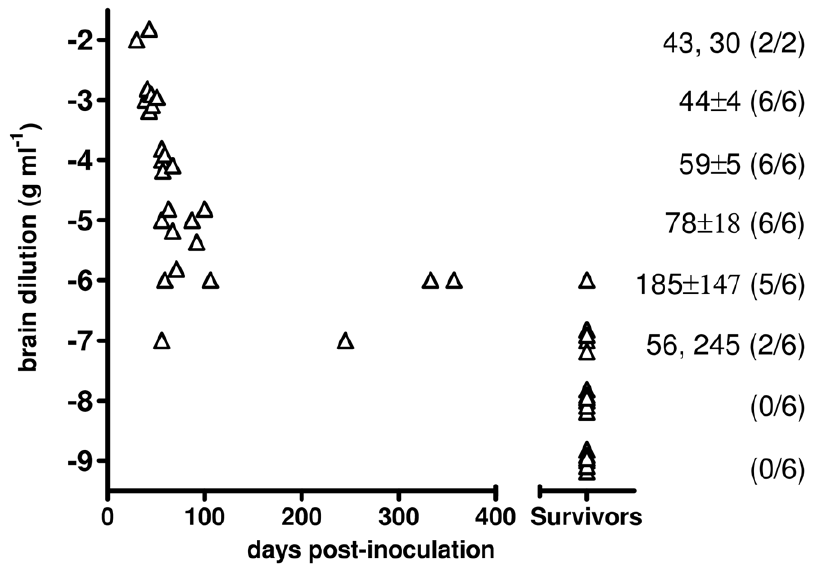
Figure 5. End-point titration of Bv 109I CWD infectivity in Bv109I. Triangles represent individual survival times. Voles that did not show signs of infection after 450 d.p.i. are plotted in compressed form after the x axes break point. The mean survival times (days 6 standard deviation) and the numbers of diseased/inoculated voles are indicated on the right of each chart.